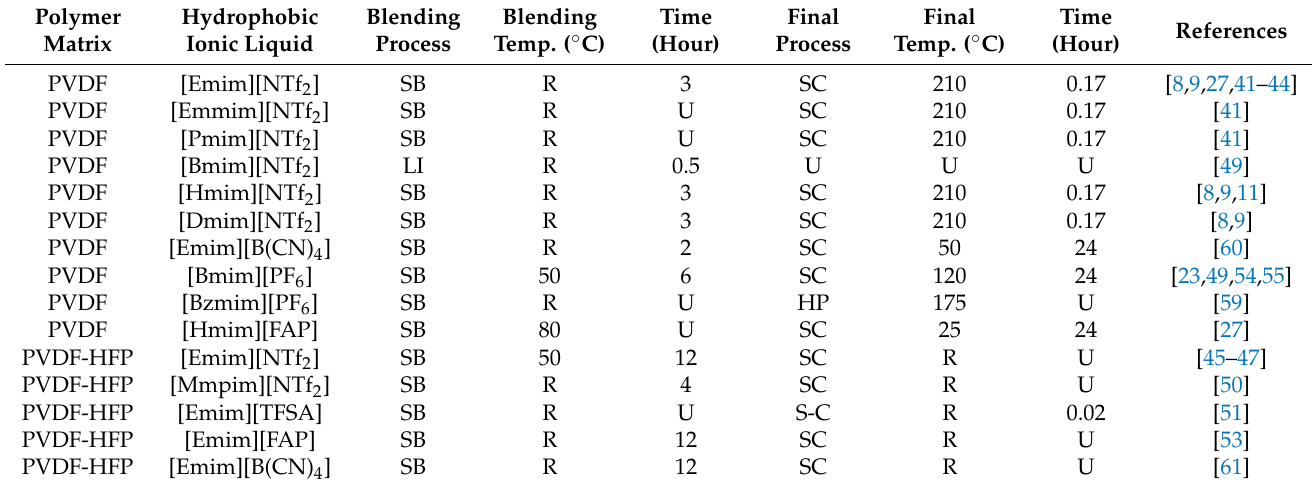
Table 5. Types of polymer matrices, hydrophobic imidazolium-based ionic liquids, and preparation processes of PVDF and PVDF-HFP blends.